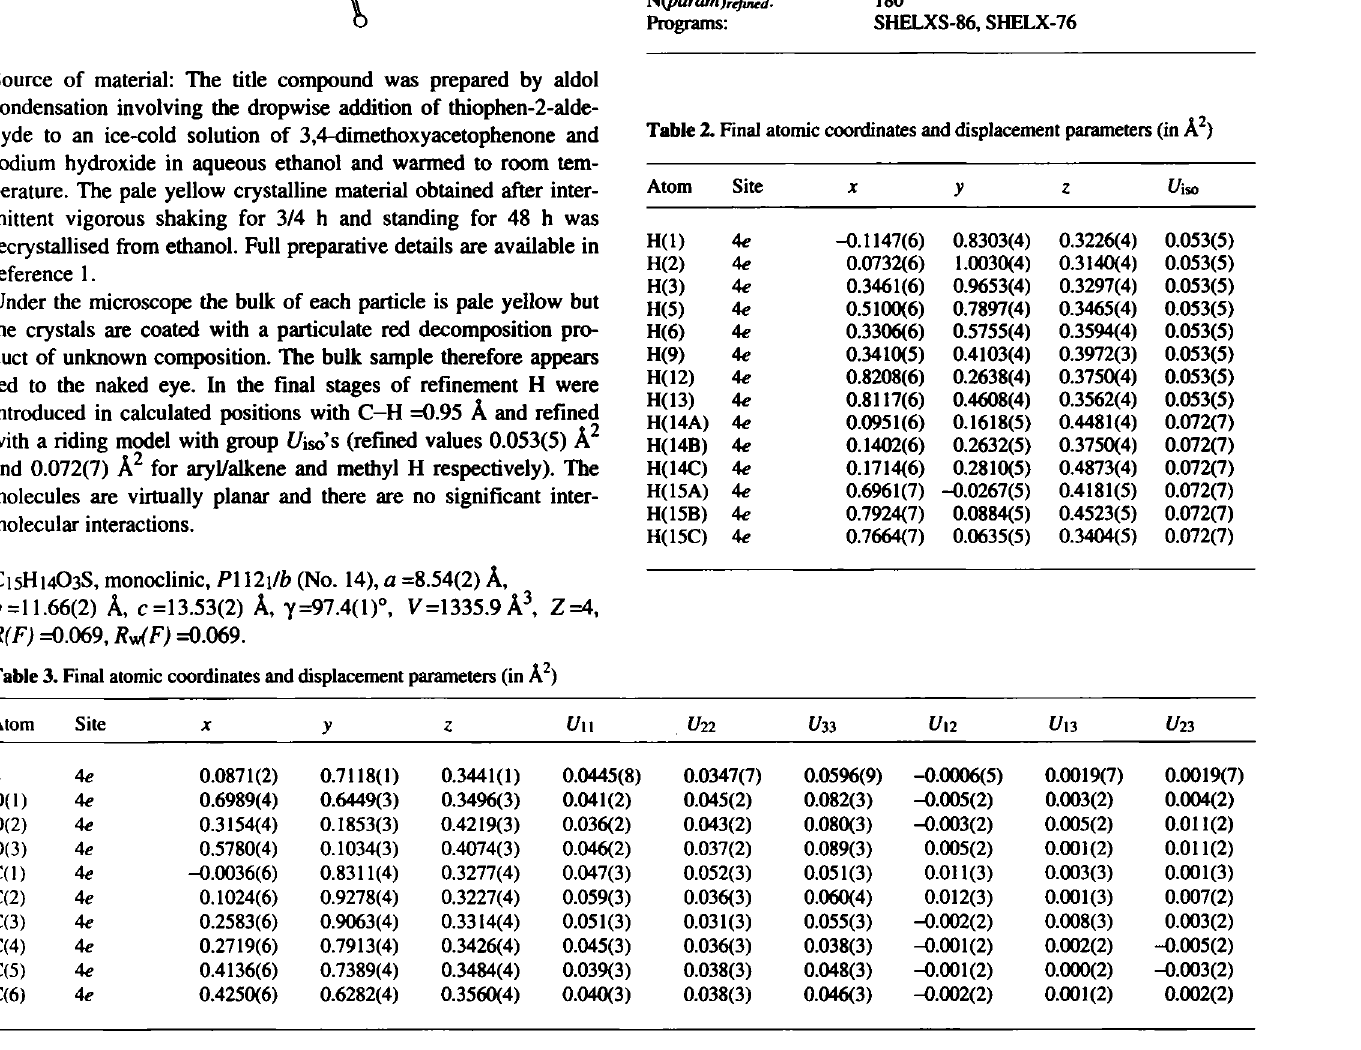
Table 3. Final atomic coordinates and displacement parameters (in Â 2 )